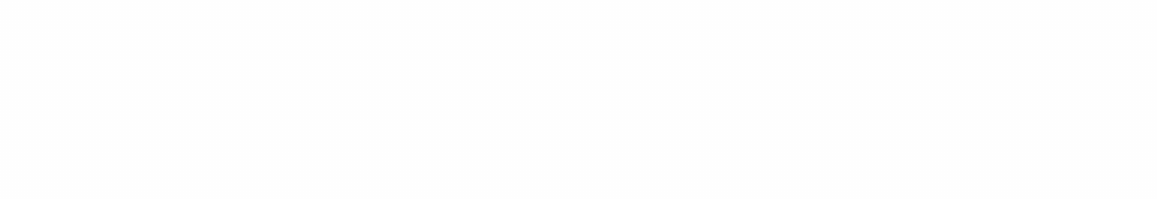
cytes receive signals in vivo to become migratory.